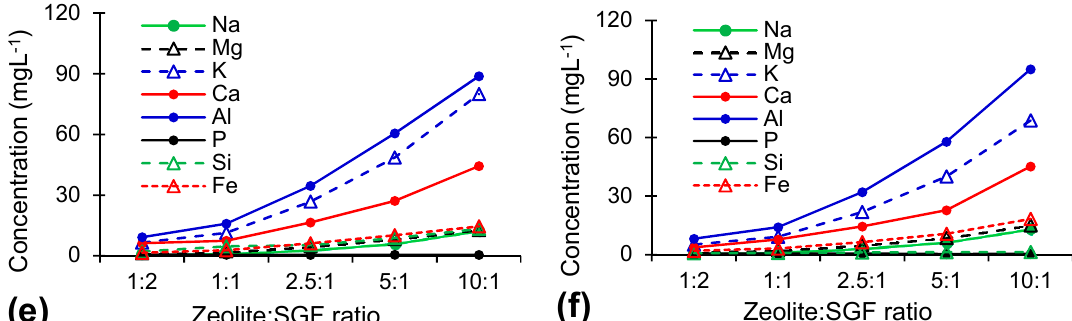
Figure 5. Influence of zeolite:SGF ( w : v ) ratio on the element dissolution with an exposure time of 7 days for ( a ) raw zeolite (RZ), ( b ) zeolite thermally treated at 450 o C, ( c ) zeolite thermally treated at 500 o C, ( d ) zeolite thermally treated at 600 o C, ( e ) zeolite thermally treated at 750 o C, and ( f ) zeolite thermally treated at 800 o C.